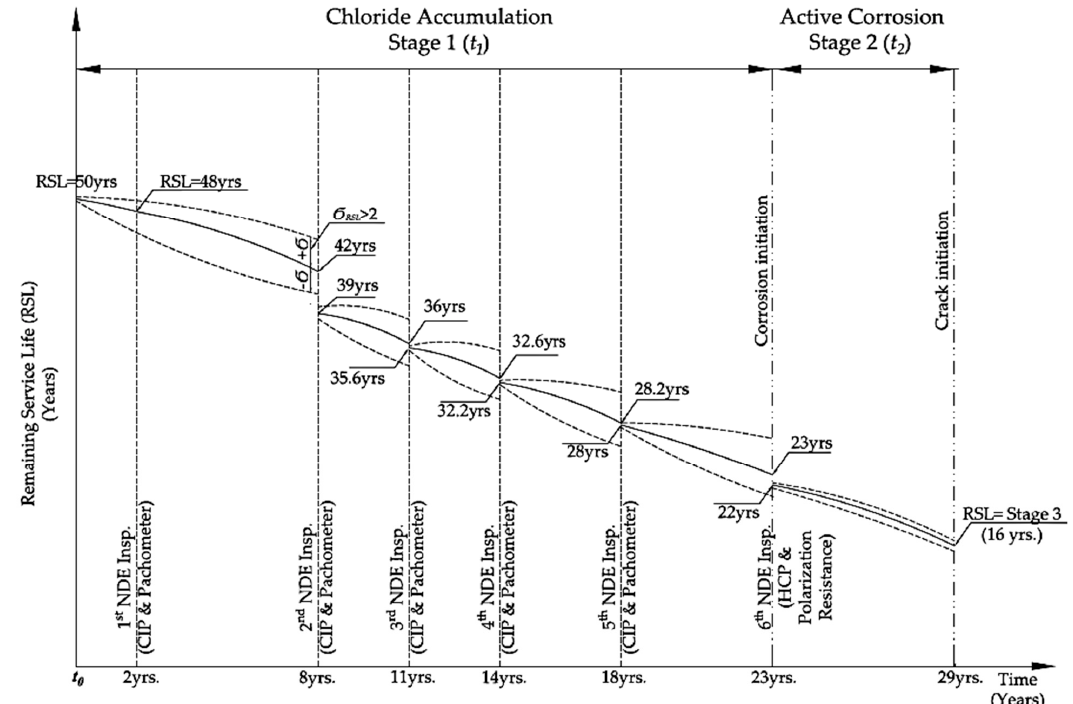
Figure 5. Illustration of inspection planning process for Stage 1 and Stage 2. The solid lines in the figure represent the mean RSL predicted with deterioration model, while the dotted lines represent the uncertainty in the prediction.